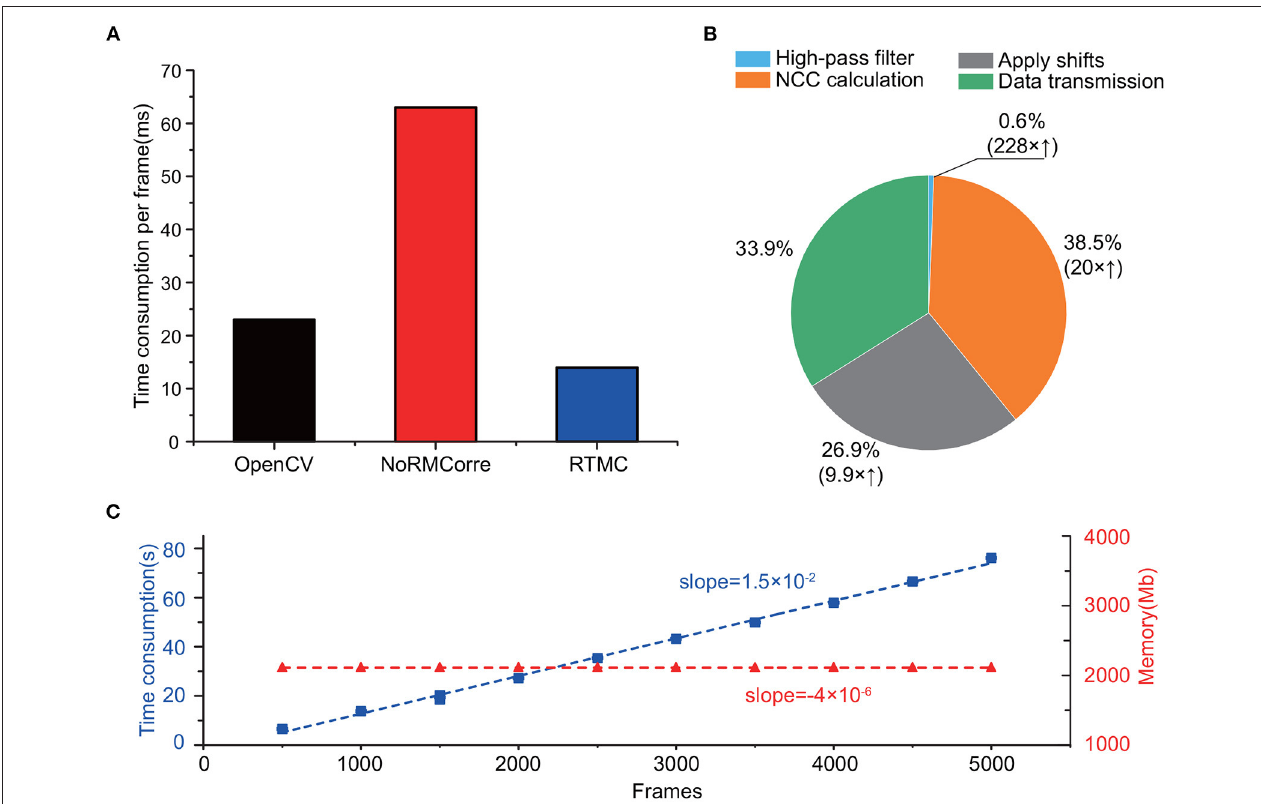
FIGURE 5 | Computing speed and resources of RTMC. (A) : Time to process one frame with OpenCV template matching, rigid NoRMCorre and RTMC. (B) : The proportion of time consumed by each step while registering one frame in the RTMC workflow. The parentheses indicate the speed enhancement of the GPU over the CPU. (C) : Cumulative time consumption (blue, square dots) and memory occupation (red, triangle dots) of RTMC, measured per 500 frames. The dashed lines indicate the linear